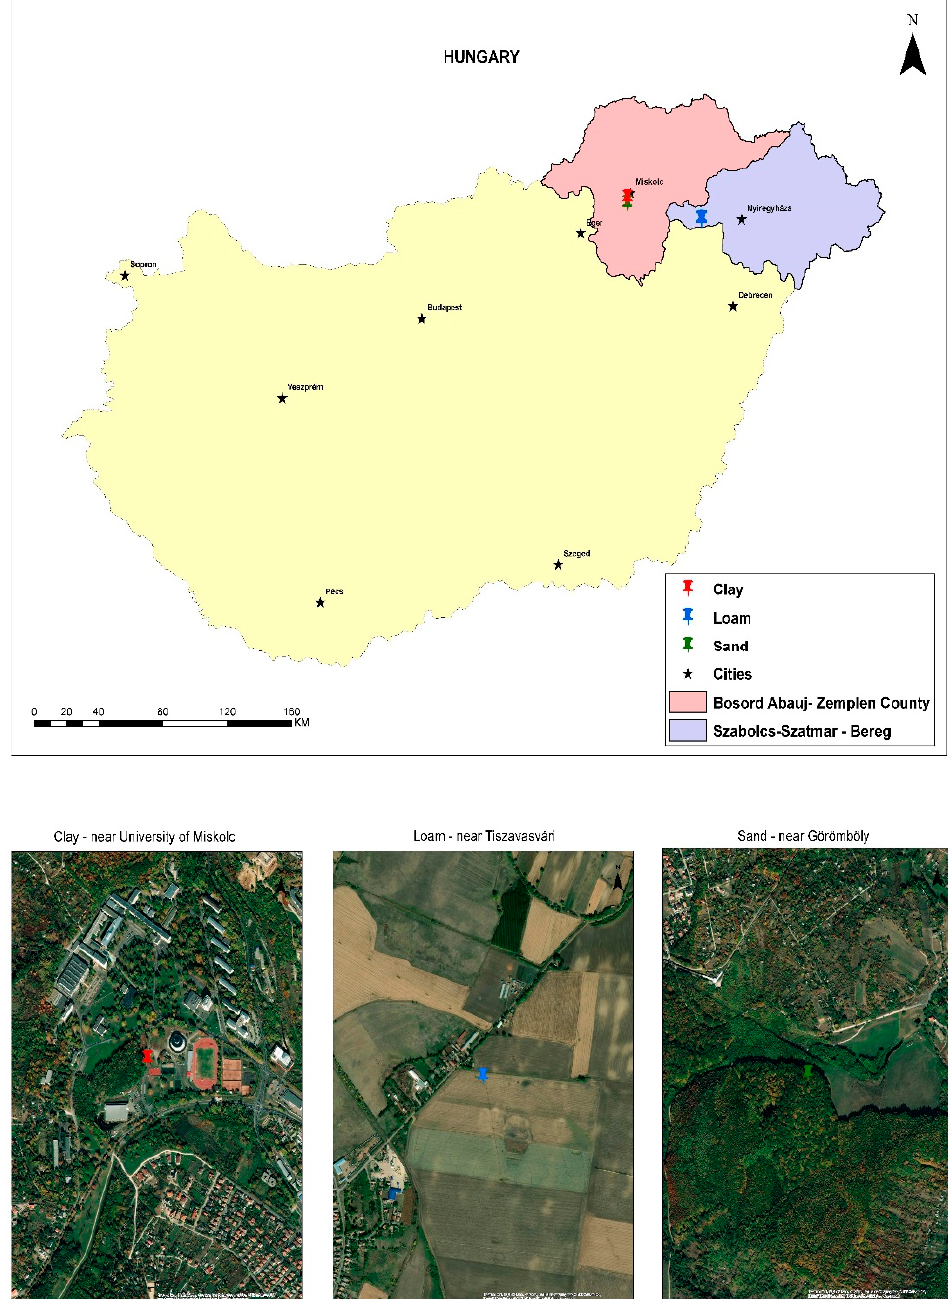
Figure 1. The locations of the study areas within Hungary.